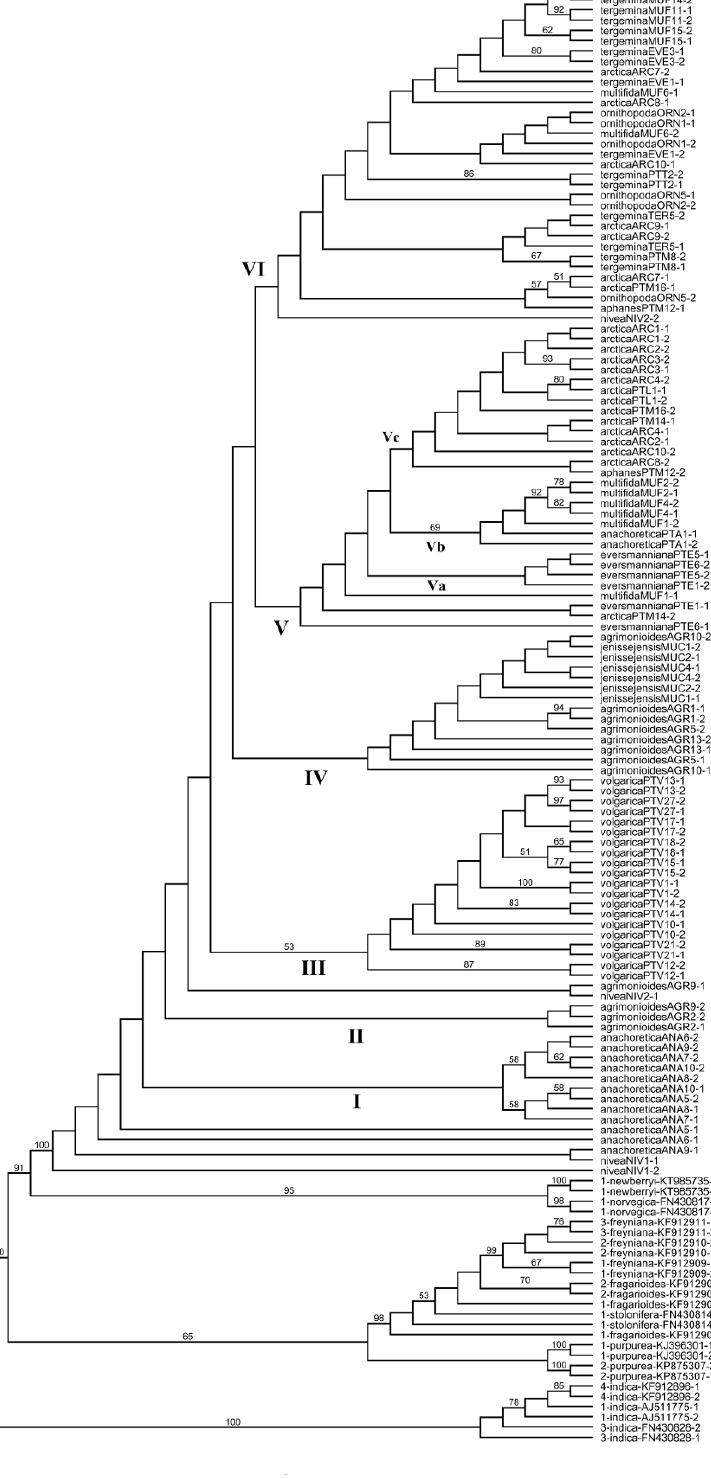
Figure 4. Maximum likelihood tree of Potentilla multifida agg. based on ITS data. Terminal names within the ingroup are followed by accession designations as in Table A1 and Figures 1 or 2 indicating reconstructed alleles. Major clades corresponding to species are designated with Roman numerals. Bootstrap support higher than 50% is indicated above branches.